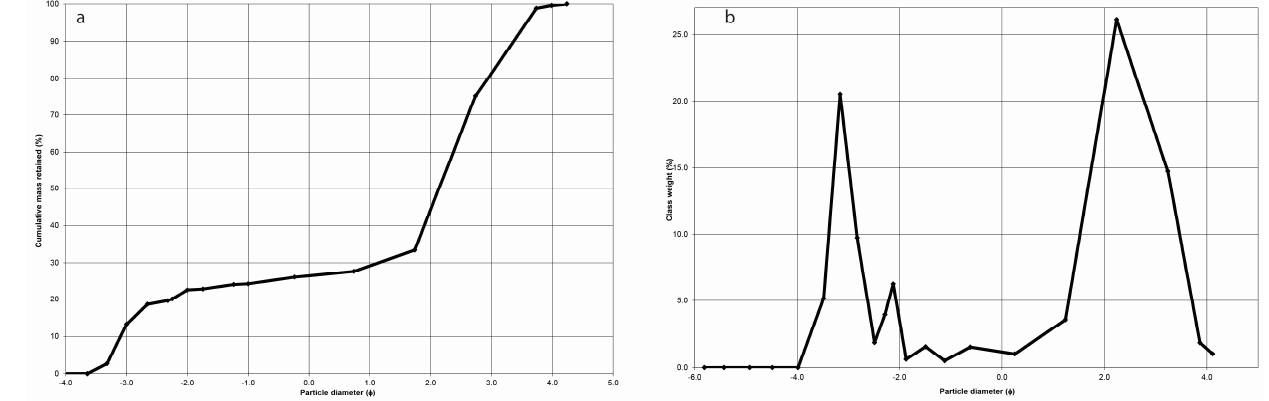
Figure 8. Cumulative (phi) and Distribution (phi) curves. ( a , b ) sample AK12/SD. The primary dunes are followed by coppice dunes which considered as the initial stage of the formation of new foredunes [50] (Figure 7). Their maximum height reaches approximately 4 m. No visible layers of sedimentation were observed. After the grain size analysis, the eastern coppice dunes (AK13/SD and AK14/SD) are characterized as Unimodal, moderately well sorted, fine sand (Figure 9).